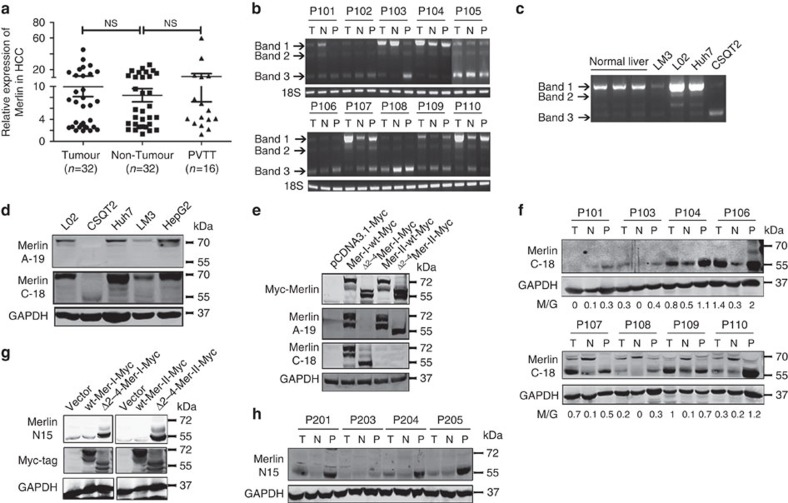
The alternative splicing of Merlin in HCC is determined by PCR and western blotting.(a) Expression of the Nf2 gene in HCC, HCC without PVTT and HCC with PVTT tissues. (b) Detection of the sizes of NF2 from HCC, adjacent and PVTT tissues by primers designed from the Nf2 exon 1 and 5. (c) The splicing patterns of Nf2 in normal liver, HCCLM3, Huh-7, CSQT2 and L02 cells. (d) Detection of expression of Merlin and its mutant in HCC cell lines (CSQT2, Huh-7, HCCLM3 and HepG2 cells), and hepatocyte L02 cells by antibodies (C-18 and C-19). (e) Detection of wtMerlin and Δ2–4Merlin by different antibodies. (f) Detection of the expression of Merlin and its mutant in HCC, PVTT and tumour adjacent tissues by antibody C-18. (g) Detection of Δ2–4Merlin by specific antibody for Δ2–4Merlin (Merlin-N15). (h) Detection of expression of Δ2–4Merlin in HCC, PVTT and tumour adjacent tissues by Merlin N15 antibody. T: HCC tumour; N: non-tumour adjacent tissues; P: PVTT; M/G: Merlin/GAPDH density.